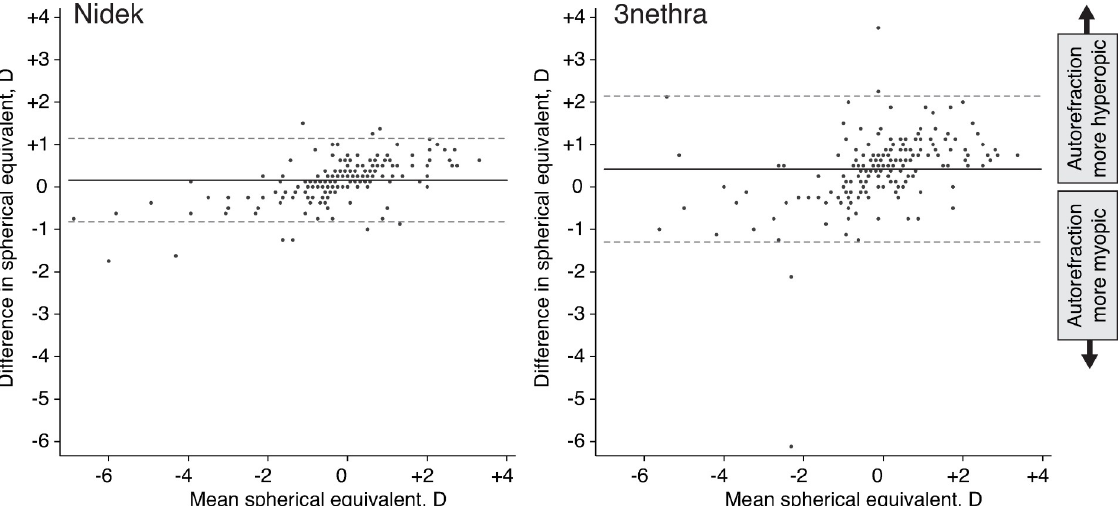
Fig 1. Bland-Altman plots with 95% limits of agreement for (A) subjective refraction and 3Nethra autorefractor and (B) subjective refraction and Nidek autorefractor. https://doi.org/10.1371/journal.pone.0251583.g001 sensitivity (Fig 2 middle row) and specificity (Fig 2 bottom row) across most of the tested thresholds of refractive error. For example, the sensitivity of the Nidek was 94.6% for detection of 1 diopter of myopic spherical equivalent, 85.7% for 1 diopter of hyperopic spherical equiva- lent, and 89.6% for 1 diopter of astigmatism; corresponding values for the 3Nethra were 89.2%, 89.3%, and 79.2% (Table 3). The specificity of the Nidek was 92.5% for detection of 1 diopter of myopic spherical equivalent, 92.9% for hyperopic spherical equivalent, and 85.8% Table 2. Mean difference and 95% limits of agreement (LOA) between measurements from subjective refraction and autorefraction. Nidek autorefractor minus